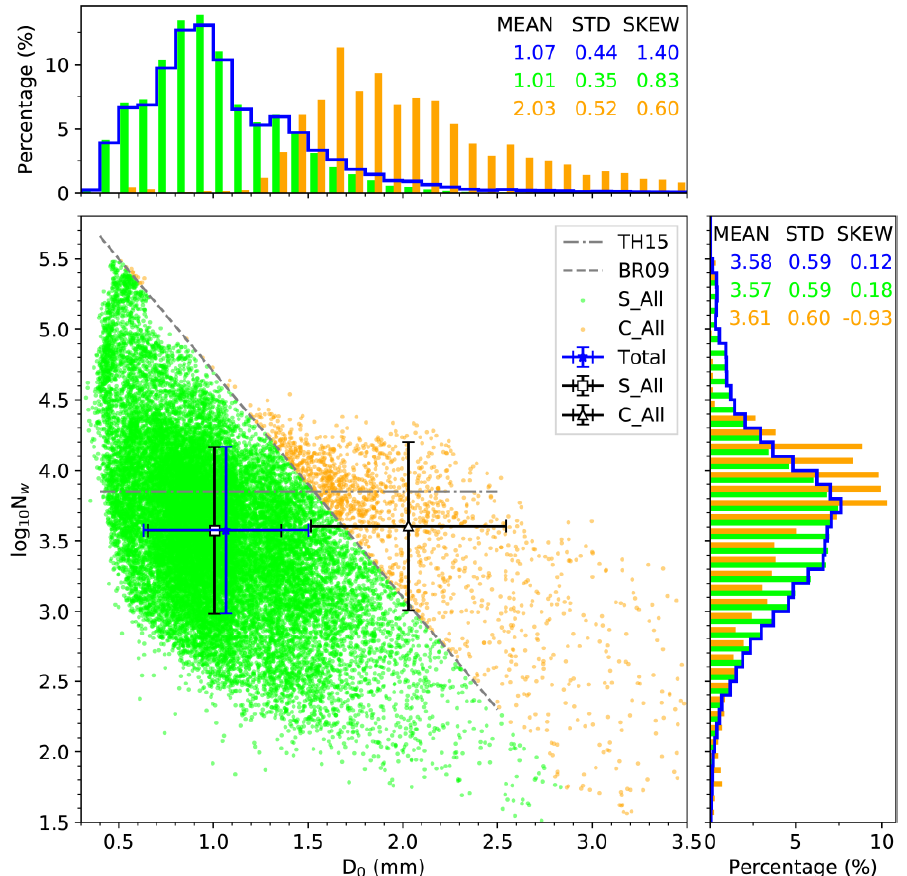
Figure 4. Scatterplot of log N w vs. D 0 for stratiform (S_All, lime) and convective (C_All, orange) rain in the bottom left panel, as well as the corresponding relative frequency histograms in the top and bottom right panels. The unit of 𝑁 𝑤 is m – 3 mm – 1 . Rain types were classified by BR09 scheme. The C_All (S_All) dataset equals to the dataset of C_BR09 (S_BR09) denoted in Table 2. Blue curves in each histogram indicate the relative frequency of the entire dataset for log N w and D 0 . The mean (MEAN), standard deviation (STD) and skewness (SKEW) for the entire dataset, stratiform rain and convective rain are shown in colors in each histogram panel, whereas the MEAN values of log N w vs. D 0 together with the respective ± 1 × STD values are plotted as error bars. The dashed and dot-dashed grey lines represent the C − S separation lines of BR09 and TH15, respectively.